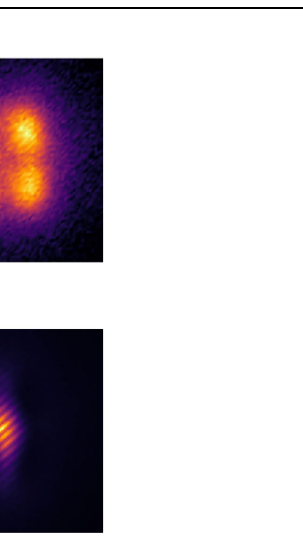
calculated spatially resolved spectra considering purely the linear dynamics with P 0 =12 γ ( c ), and the occurrence of stimulated energy relaxation with P 0 =20 γ and η =10 μ m/(meVfs) ( d